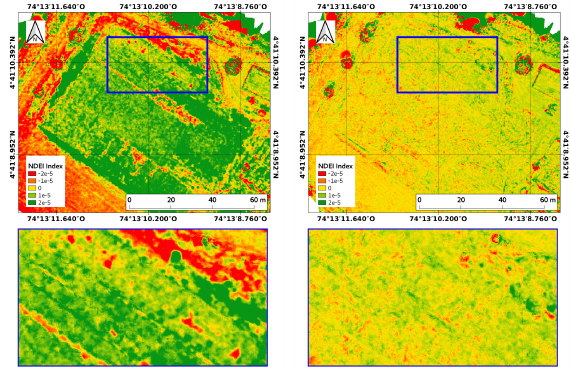
Figure 12. NDEI index: (a) Flight 4 vs Flight 1 (b) Flights performed on December 28, 2019; (c) Flights performed